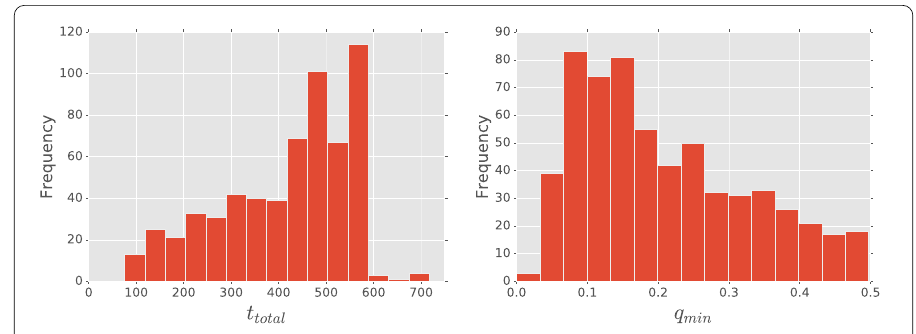
Figure 1 Population statistics. Left panel: the distribution of the number of days that the participants took part in the experiment. Right panel: the distribution of the fraction of missing data for (cid:3) t = 15 min.